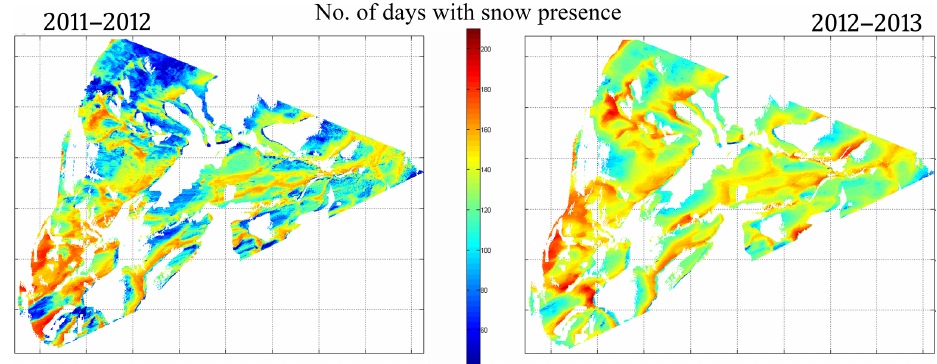
Figure 7. Number of days with snow present for each pixel for 2011/12 and 2012/13 snow